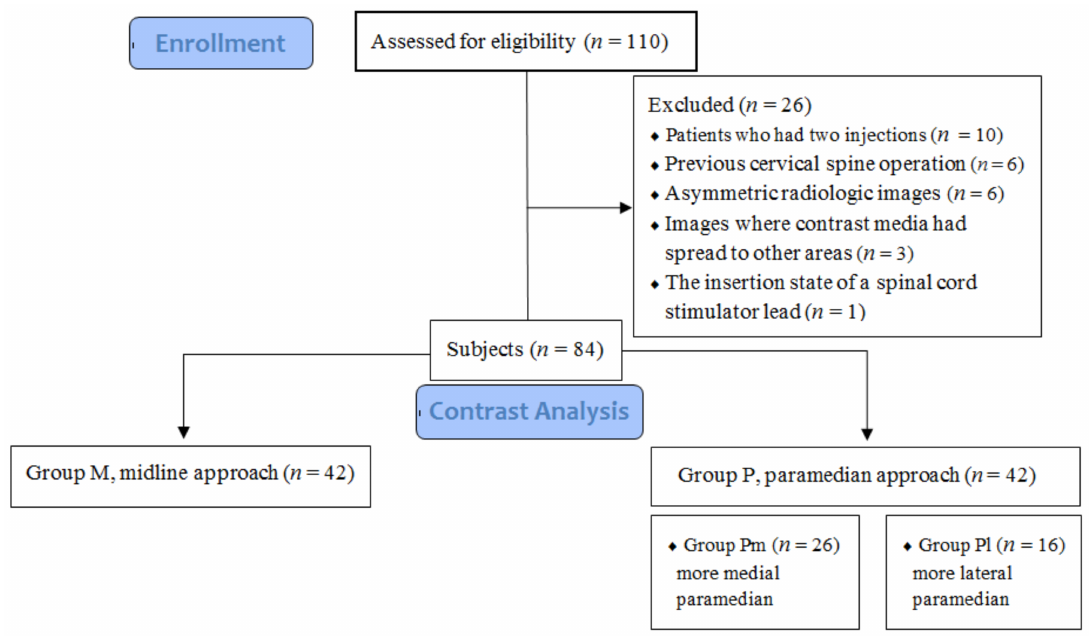
Figure 1. Flow diagram of the